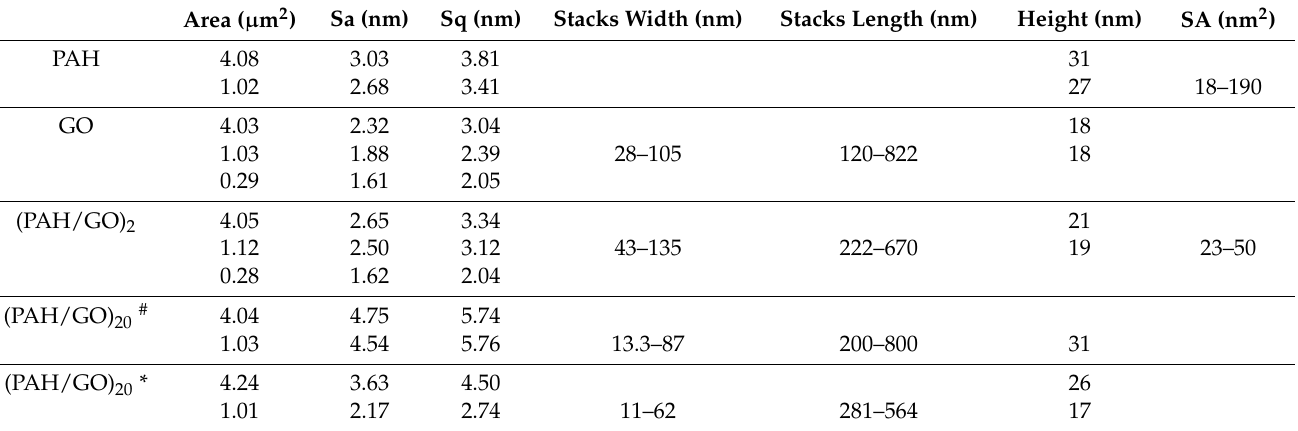
Table 3. Summary of mean square roughness values (Sq), mean roughness (Sa), surface area and fiber size and agglomerate’s area (AA), observed in the morphologically AFM characterized thin